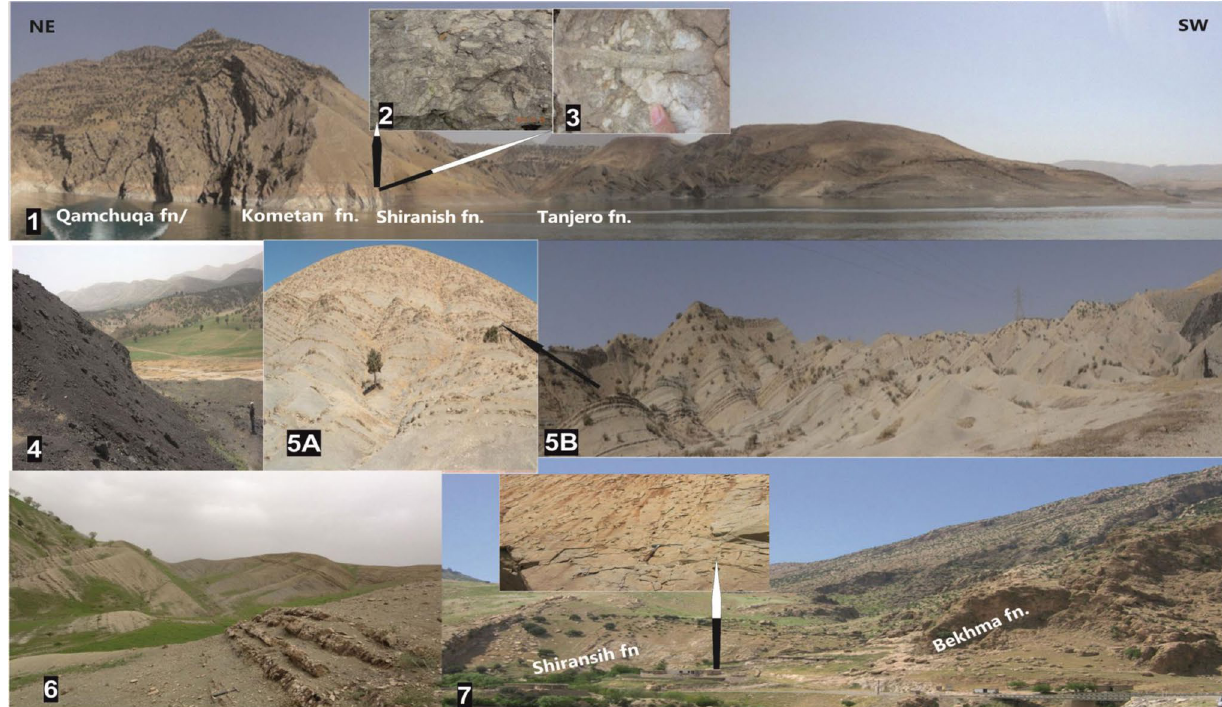
Fig. 3 1. Qarasirt section/Dokan lake, high folded thrust zone. 2. Hard ground surface at the base of Shiranish fn. 3. Glauconite at the Kometan/Shiranish formations boundary. 4. Bitumen seeps from marl-dominated part, Shiranish fn. (Alasiaw section). 5a. Increasing of carbonates at the upper parts of the Shiranish fn, imbricated zone. 5b. Marl-dominated sequence in the lower part of Shiranish fn.